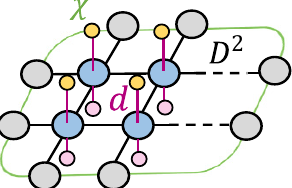
FIG. 4. Graphical representation of the computation of a sin- gle element (cid:3) V ( i ) | ρ | V ( j ) (cid:2) on an iPEPS. The system in the figure is a rectangle system of height h = 2 (and a general width w ). The local vectors | v [ α ] (cid:2) are represented by the yellow and pink one-legged circles, where the two sets of local vectors are independent of each